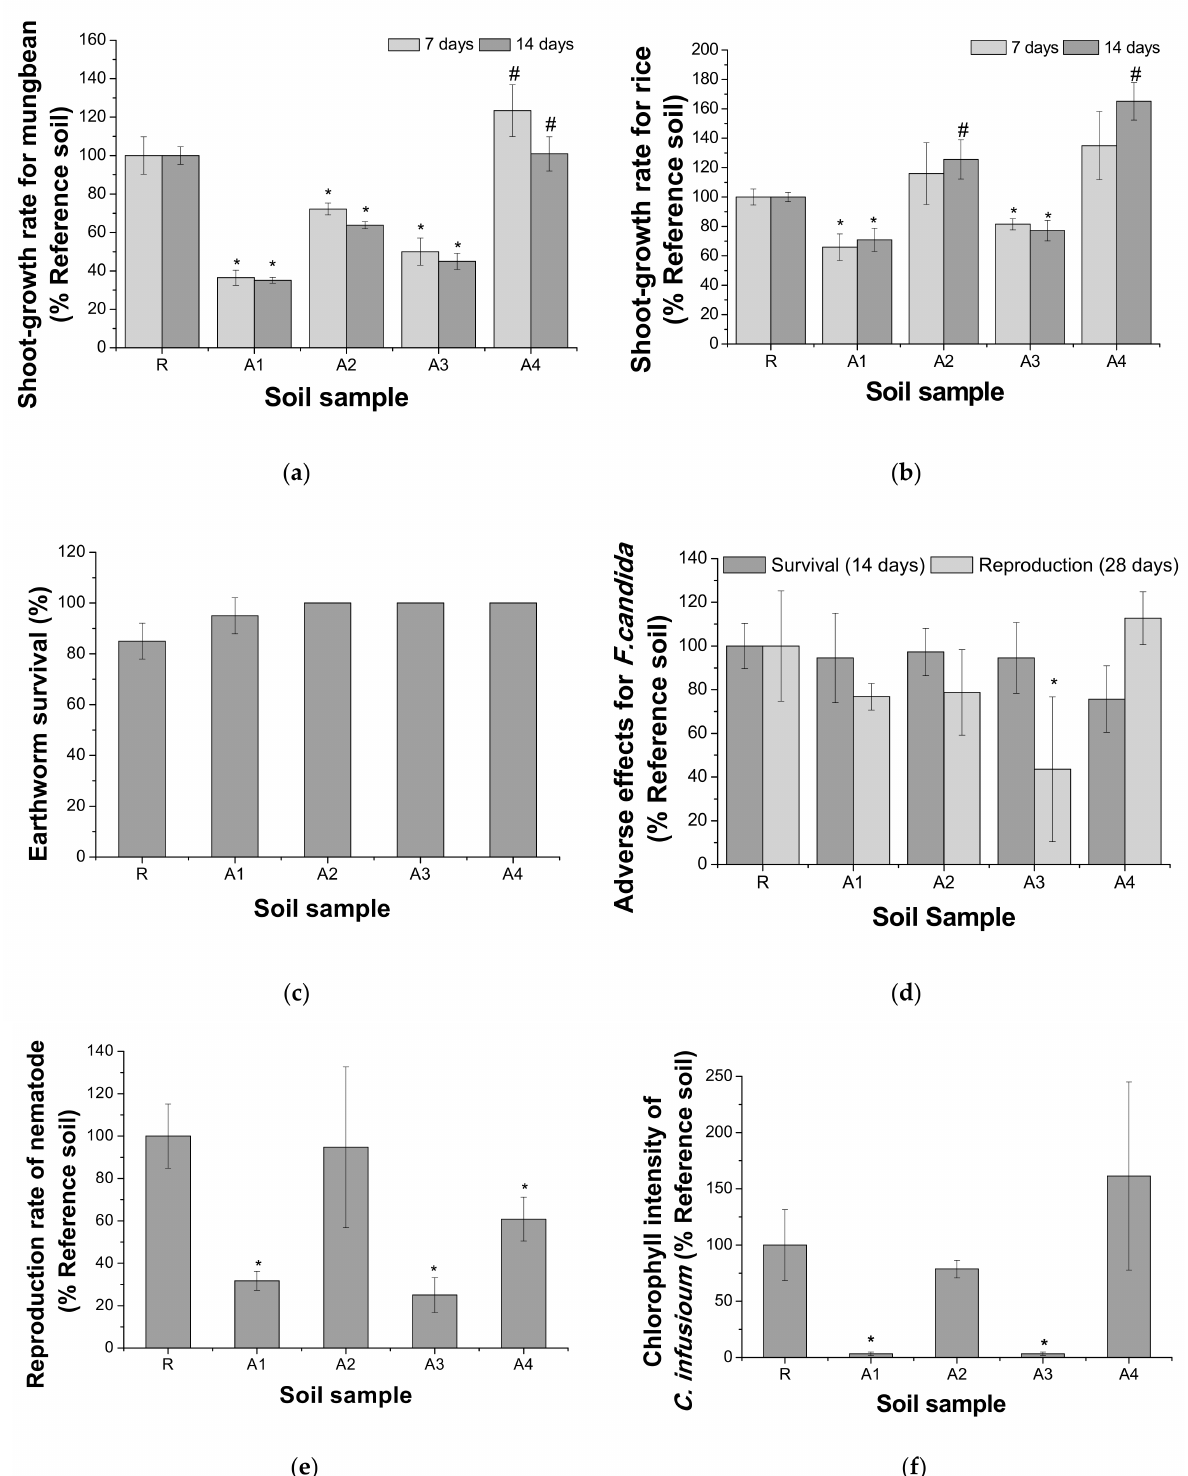
Figure 2. Soil bioassays using soil organisms, where ( a ) and ( b ) show the growth rates in plant assays on mung bean ( V. radiata ), and rice ( O. sativa ) after a 7-day (left) and 14-day exposure (right), respectively, ( c ) shows the survival rate of earthworms ( E. andrei ) after a 14-day exposure, ( d ) represents the adverse effects on collembola ( F. candida ) after 14 days (left; the survival of adults) and 28 days (right; the reproduction of juvenile), and ( e ) and ( f ) show the reproduction rate of the soil nematode ( C. elegans ) after a 24 h exposure and the chlorophyll intensity of soil algae ( C. infusionum ) after a 6-day exposure, respectively. Line bars indicate standard deviation, and the asterisk (*) indicates a significant adverse effect compared with the control (R). The hash (#) indicates a significant positive effect compared with the